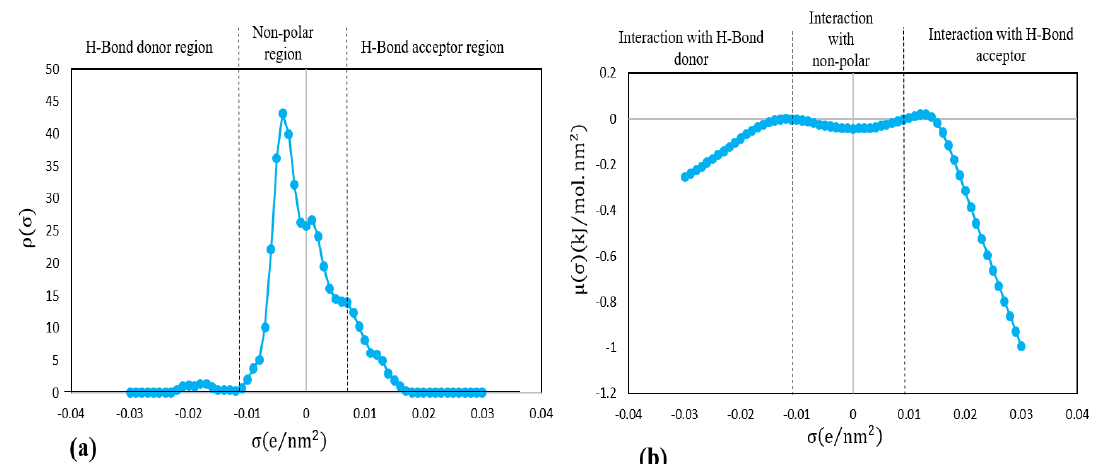
Figure 4. Net surface charge of DHA in terms of ( a ) σ -profiles and ( b ) σ -potential.